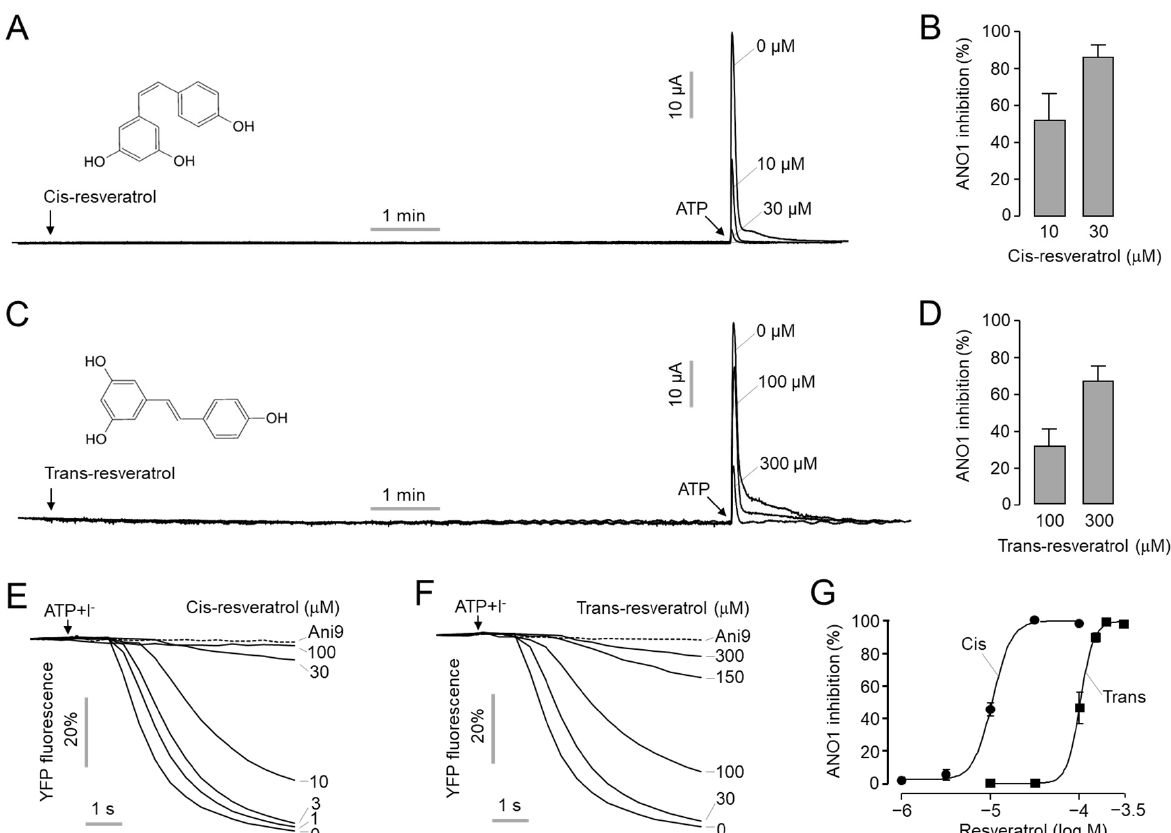
Figure 1. Inhibition of ANO1 activity by cis - and trans -resveratrol. ( A – D ) Apical membrane currents were measured in human ANO1-expressing FRT cells. Indicated concentrations of cis - and trans - resveratrol were treated for 10 min before the application of 100 µ M ATP. ( B , D ) Summary of ANO1 current inhibition (mean ± S.D., n = 4–5). ( E , F ) The inhibitory effect of cis - and trans -resveratrol on ANO1 activity was measured with a YFP-quenching assay in FRT cells expressing ANO1 and a halide sensor YFP. Indicated concentrations of cis - and trans -resveratrol were added 10 min before the application of iodide solution containing 100 µ M ATP. ( G ) Summary of dose–response (mean ± S.D., n = 4).